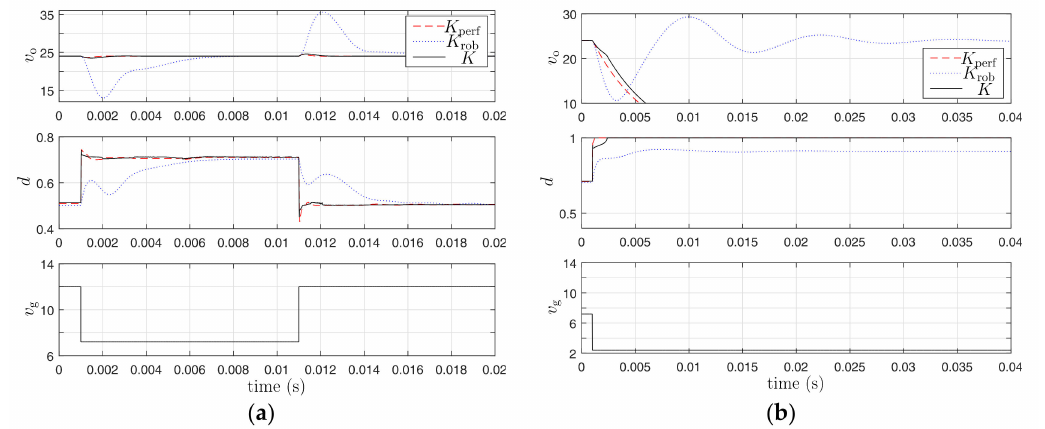
Figure 6. Simulated transient of the boost converter, in the presence of an input voltage disturbance, with the robust LQR controllers K (solid line), K perf (dashed line) and K rob (dotted line). ( a ) The input voltage steps down to 7.2 V, which corresponds to D = 0.7. All controllers consider such a change of operating point and maintain the stability. ( b ) The input voltage steps down to 2.4 V, which corresponds to D = 0.9. Only controller K rob maintains the stability of the regulation.